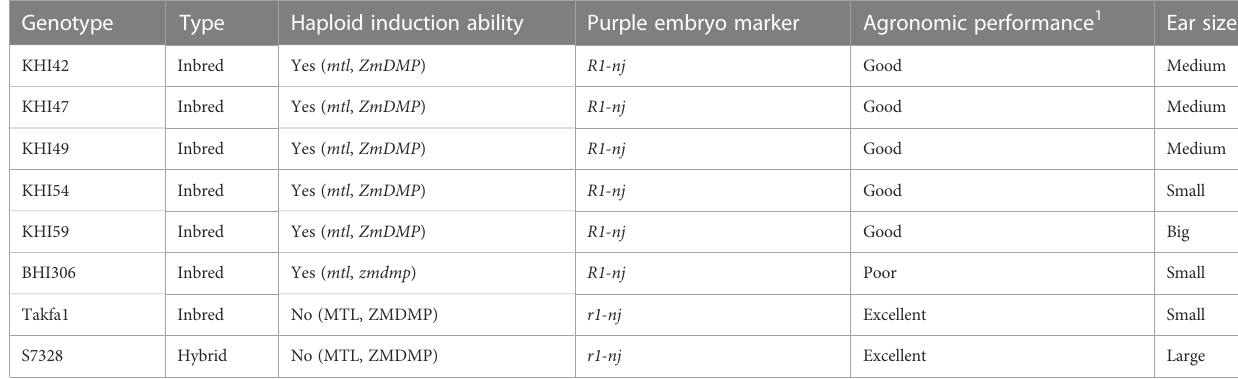
TABLE 1 Brief descriptions of six haploid inducers used in this